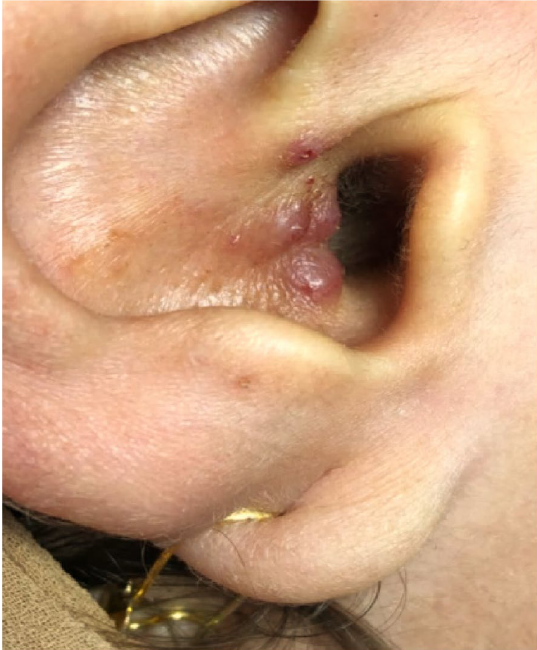
Fig. 2 Tumor consisting chiefly of a nest of basaloid cells with horn cyst (H&E; A with